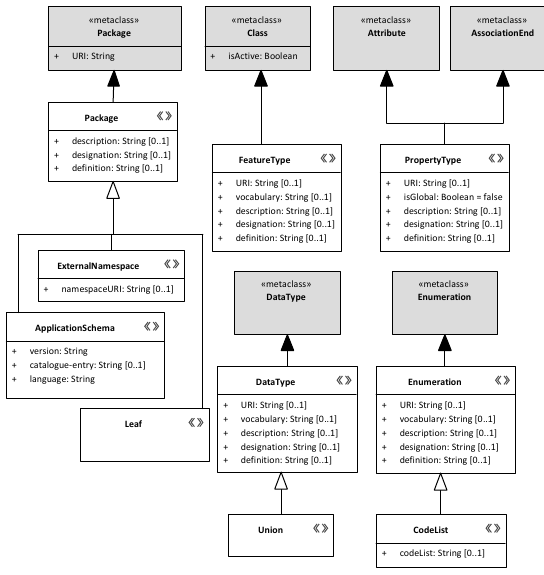
Figure 7. The Core Geospatial Profile –